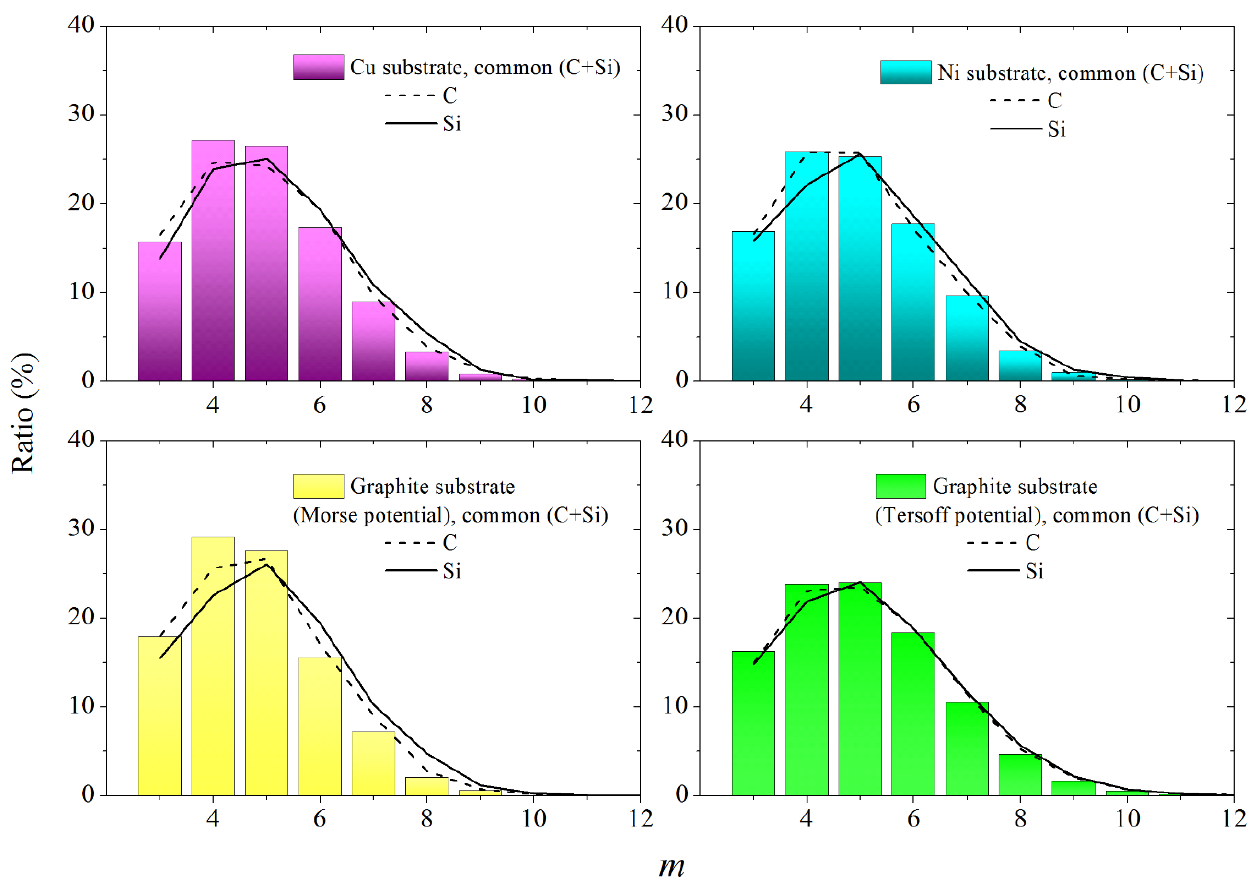
Figure 11. Distributions of VP faces over the number of sides obtained at the final stage of deposition of the SiC film on various substrates, both for the entire SiC film and for its individual components (C and Si); the interaction between Si or C atoms and a graphite substrate was carried out using Morse and Tersoff potentials.